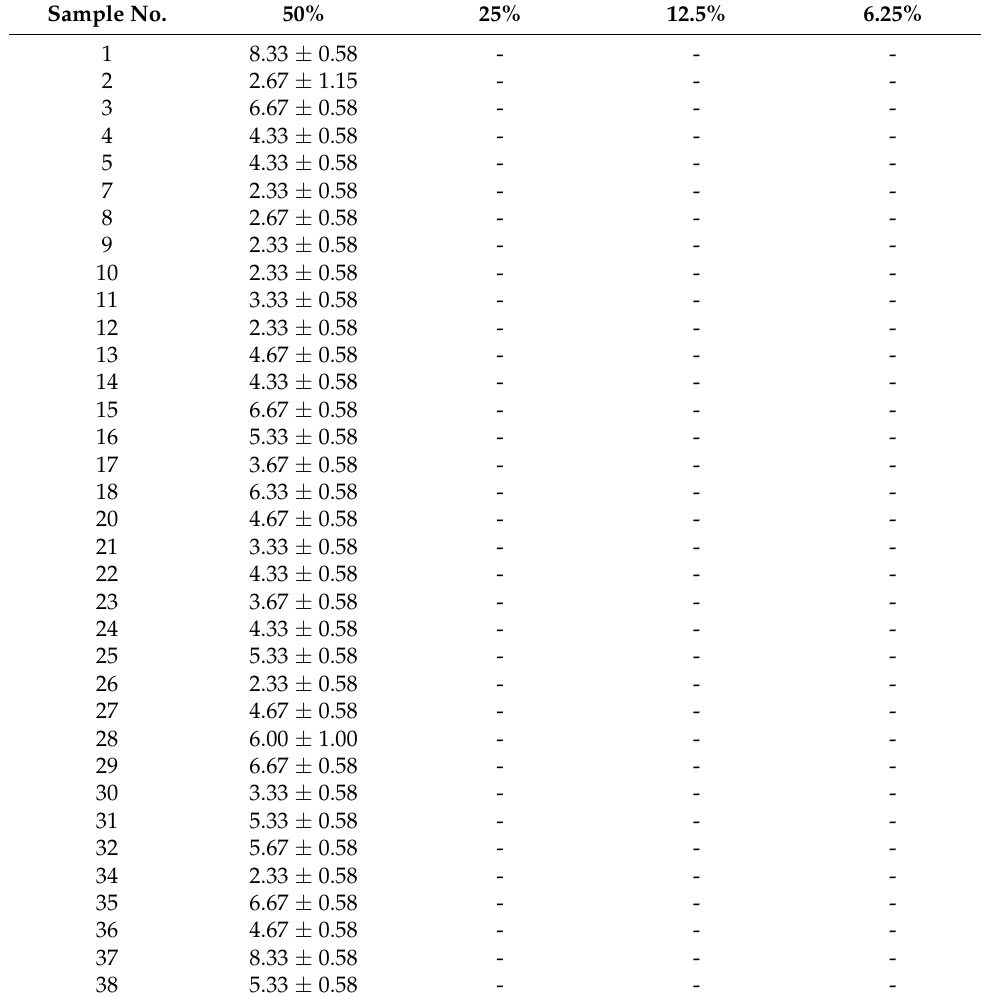
Table 9. Antimicrobial activity of samples against C. krusei in mm. Sample